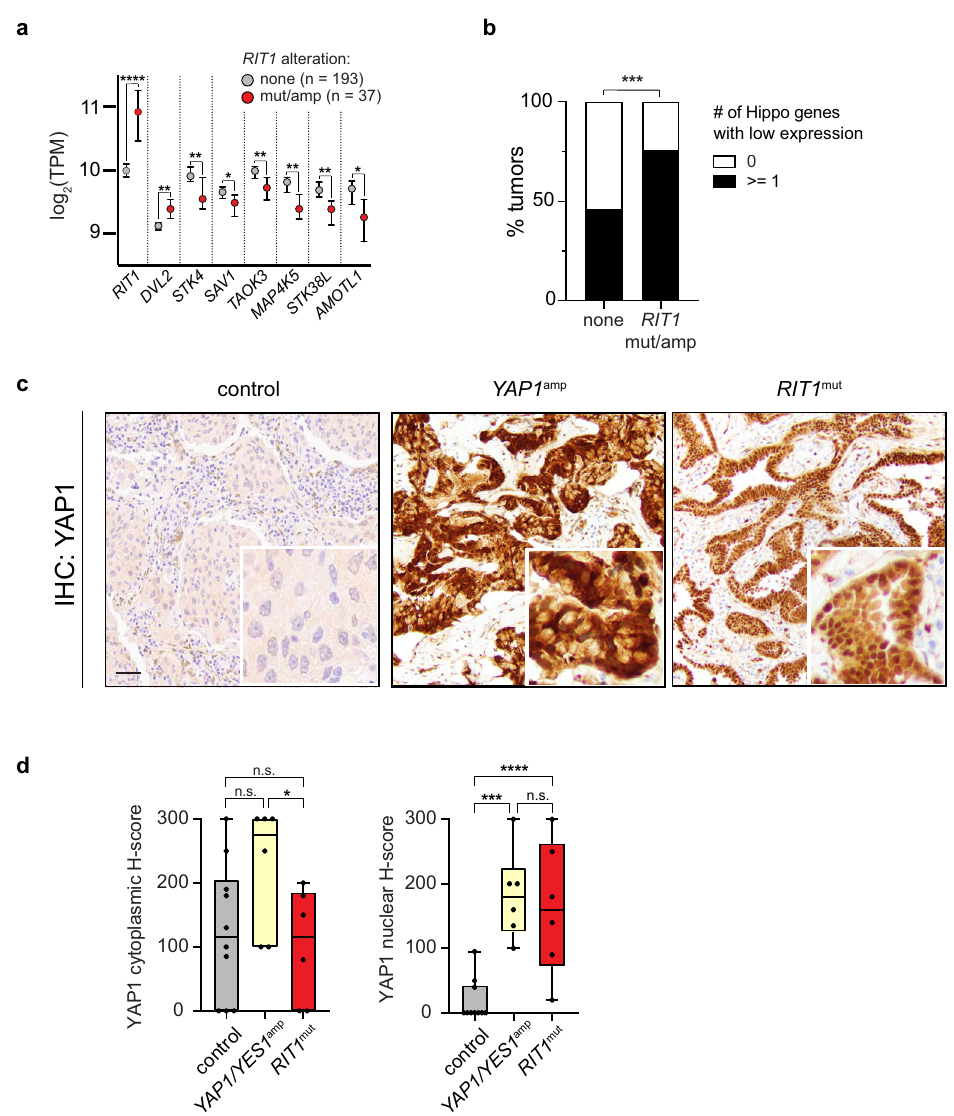
Fig. 8 Hippo pathway loss and YAP1 nuclear overexpression in RIT1-mutant human lung tumors. a RNA-sequencing data of human lung adenocarcinomas from TCGA. Data shown are the median± 95% con fi dence interval of log 2 -transformed transcripts per million (TPM) in RIT1 -altered (ampli fi ed or mutated, n = 37) tumors compared to RIT1 non-altered tumors ( n = 193). * p < 0.05, ** p < 0.01, ** * * p < 0.0001 by unpaired two-tailed t-test ( RIT1: **** p = 1.84e − 11, DVL2 : ** p = 0.0025, STK4 : ** p = 0.0011, SAV1 : * p = 0.0278, TAOK3 : ** p = 0.0052, MAP4K5 : ** p = 0.0023, STK38L : ** p = 0.0023, AMOTL1 : * p = 0.0384). b Proportion of control or RIT1 ampli fi ed or mutated (mut/amp) tumors with low expression of any one Hippo pathway gene; see Methods. *** p = 0.0006 by one-tailed Fisher ’ s exact test. c Representative low magni fi cation images and inset zoom of YAP1 IHC in human lung tumor samples, control, YAP1 -ampli fi ed, and RIT1 -mutant, scale bar = 100 µ m. n = 6 – 10 tumors per condition were analyzed d H-score quanti fi cation of control, YAP1/YES1 -ampli fi ed, and RIT1 -mutant human lung tumor samples (Supplementary Data 8). H-Score = % of positive cells multiplied by intensity score of 0 – 3; see Methods. n = 6 – 10 tumors per condition were analyzed. Box plots show the median (center line), fi rst and third quartiles (box edges), and the min and max range (whiskers). n.s., p > 0.05, * p = 0.046, *** p = 0.0009, **** p < 0.0001 by unpaired two-tailed t-test. Source data are provided as a Source Data fi